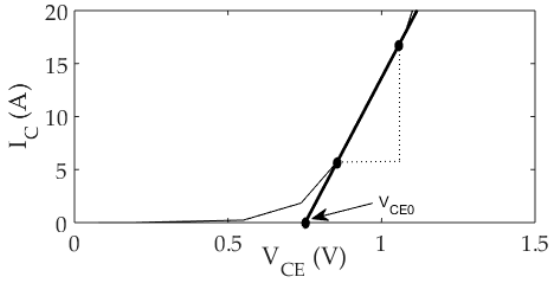
Figure 3. Linearization of V–I curves for IGBT.